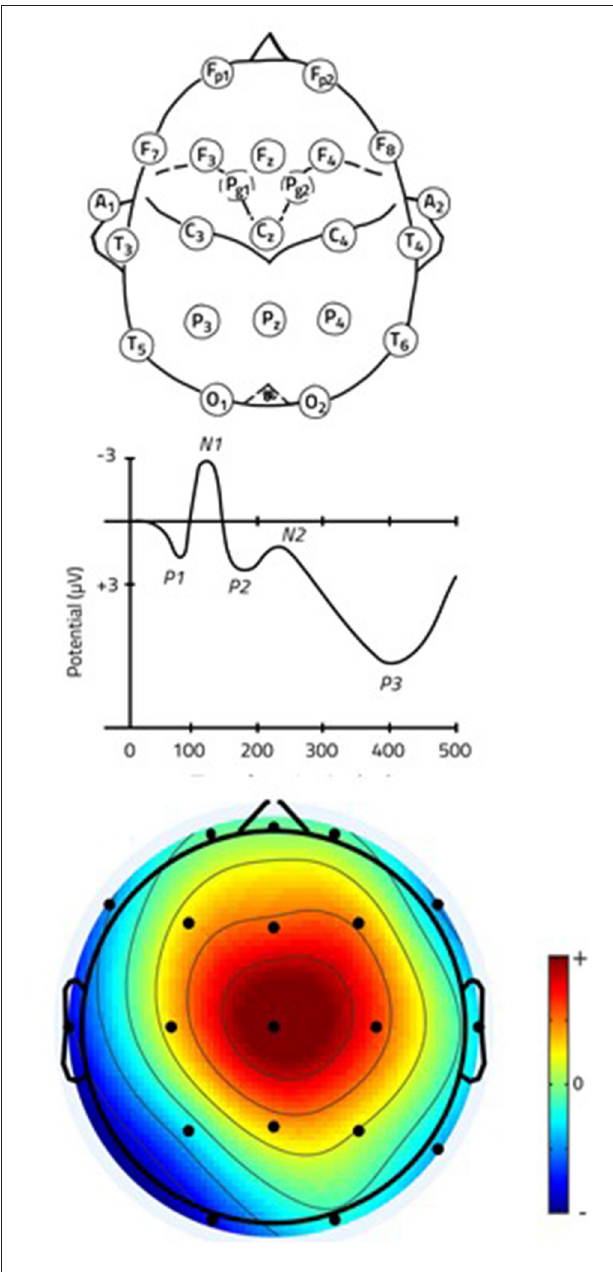
FIGURE 2 | EEG set-up, ERPs and spectral map. Top: Position of 24 electrodes according to the International 10–20 system. Front to back: Fronto-polar, Frontal, Pharyngeal, Auricular, Central, Temporal, Parietal, Occipital (Sazgar and Young, 2019); Center: Event-Related Potentials (ERPs) classified based on latency with respect to the stimulus; Bottom: Spectral map showing EEG activation at P200 latency (the color code represents the topographic distribution of the voltage